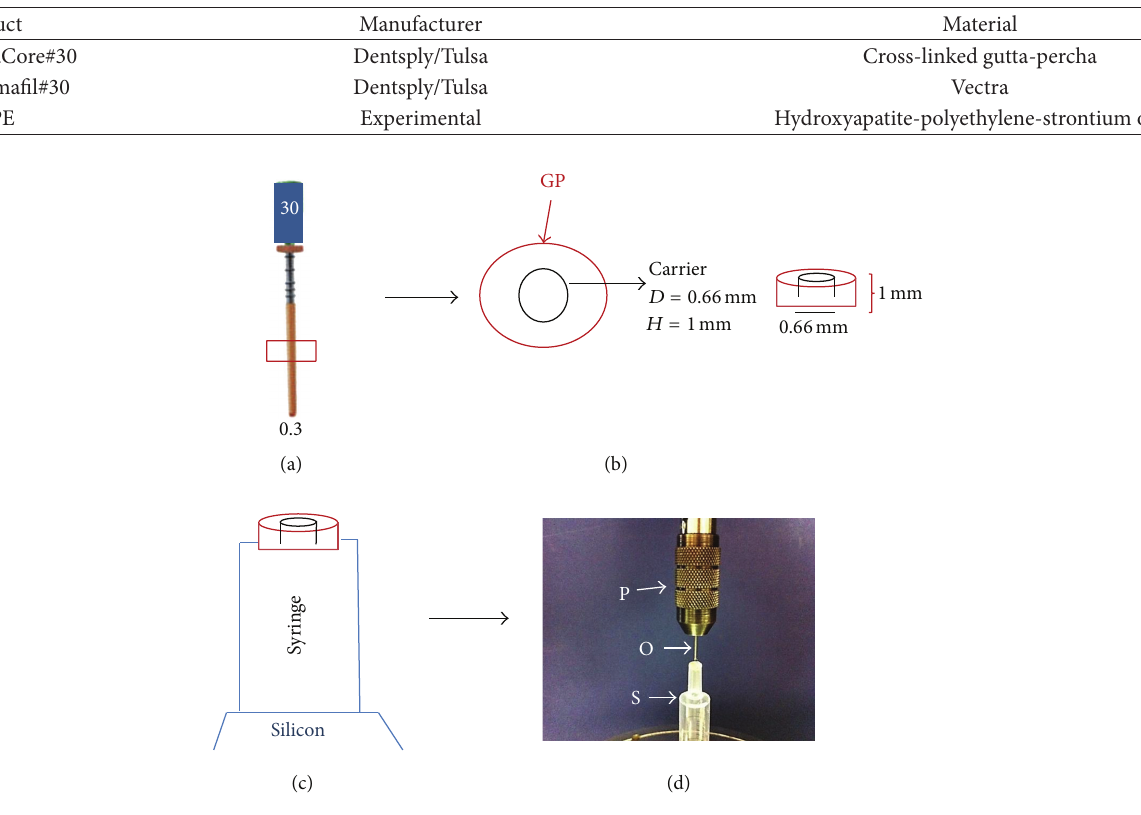
Figure 1: Schematic representation of the push-out test procedure. (a) The middle part of the endodontic obturator is chosen for the test. (b) Slices (height 1mm and diameter 0.66 mm) are obtained. (c) The slice is fitted into the aperture of a customized syringe. (d) The plunger of the Instron machine is equipped with an orthodontic wire (0.5 mm in diameter) and aligned with the slice to be tested (P = Instron plunger, O = orthodontic wire, and S = syringe holding the slice).